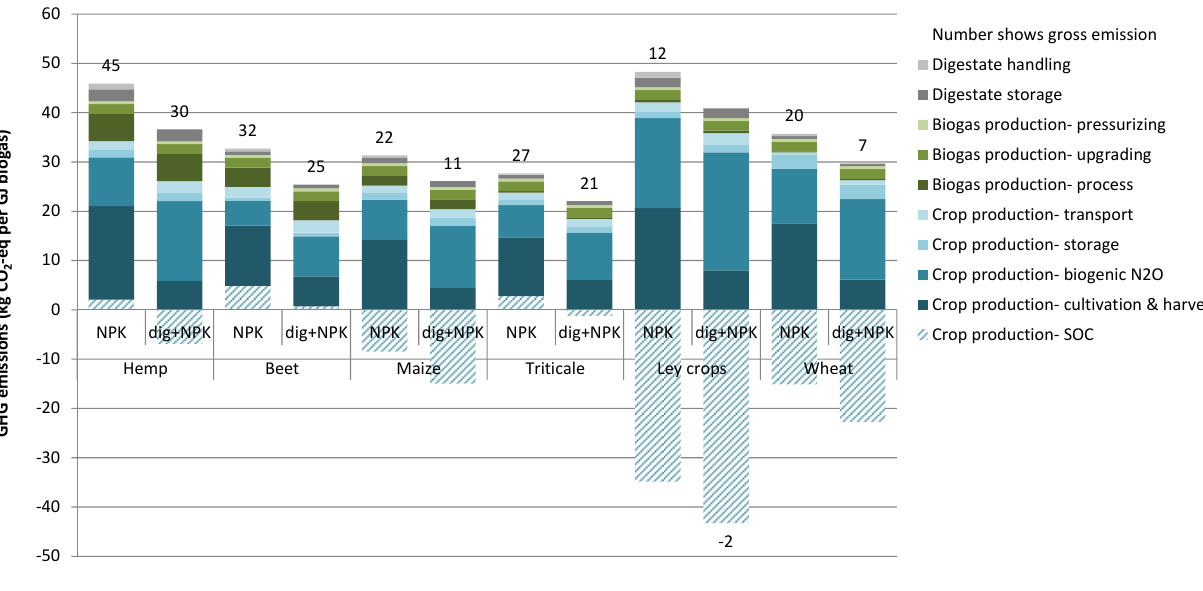
Figure 3. GHG performance of the various crop-based biogas production systems (expressed as kg CO 2 -eq·GJ − 1 biogas) for the two alternative cultivation systems; including only mineral fertiliser (NPK) and digestate complemented with mineral fertiliser (dig+NPK), respectively. The credit of increased SOC content from the crop cultivation (all systems) and digestate (dig+NPK) is shown as negative bars and the numbers above the bars show the net GHG performance including this credit. Based on Tables 2 and